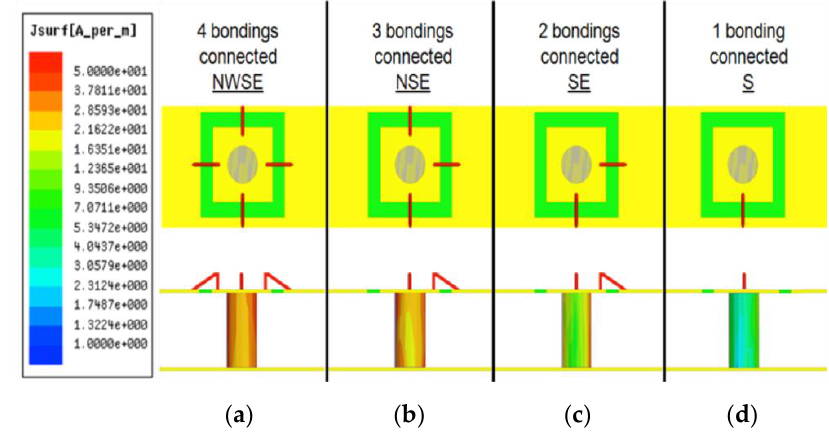
Figure 3. Electric current density along the tuning post for four cases: ( a ) four, ( b ) three, ( c ) two and ( d ) one wire bonding connected to the tuning post. Table 1. Frequency shift as a function of switched states. X post (mm) States U – S S – SE SE – NSE NSE – NWSE 1.9 Freq. Shift (MHz) 508 225 67 17 0 Freq. Shift (MHz) 1670 640 390 210